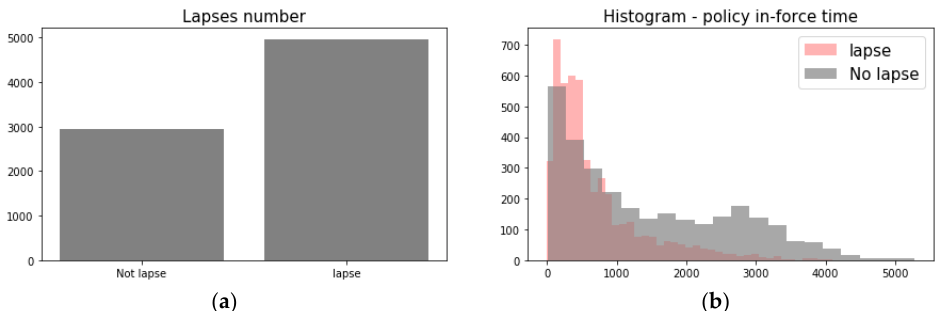
Figure 3. Response variable ( a ) event status and ( b ) policies survival time by event